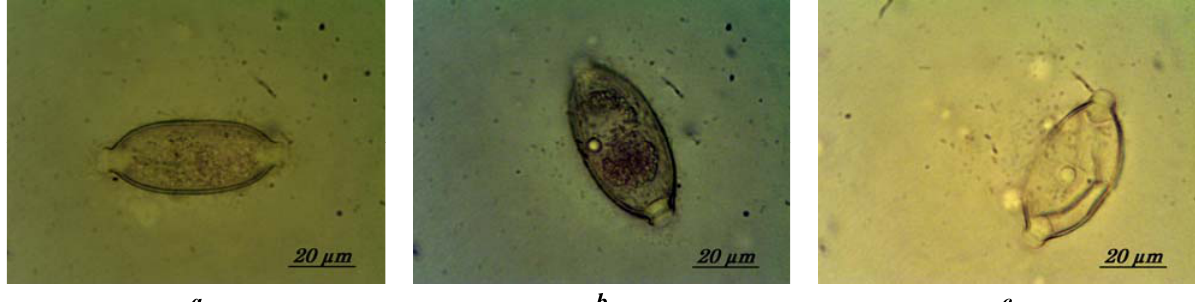
Fig. 1. Changes in the eggs of Aonchotheca bovis, isolated from gonads of females of worms, after application of chlorine-